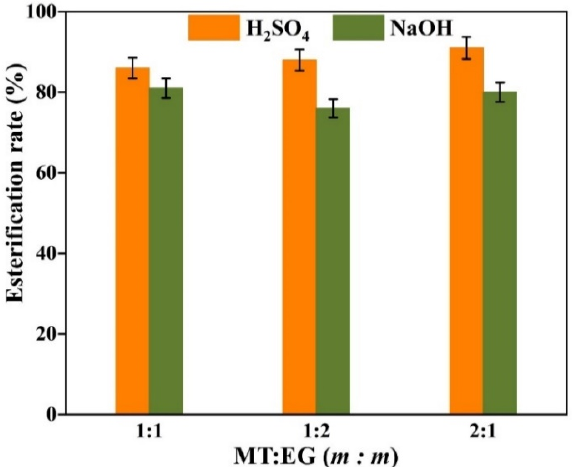
Figure 9. The effect of the proportion of alcohol on the esterification reaction.